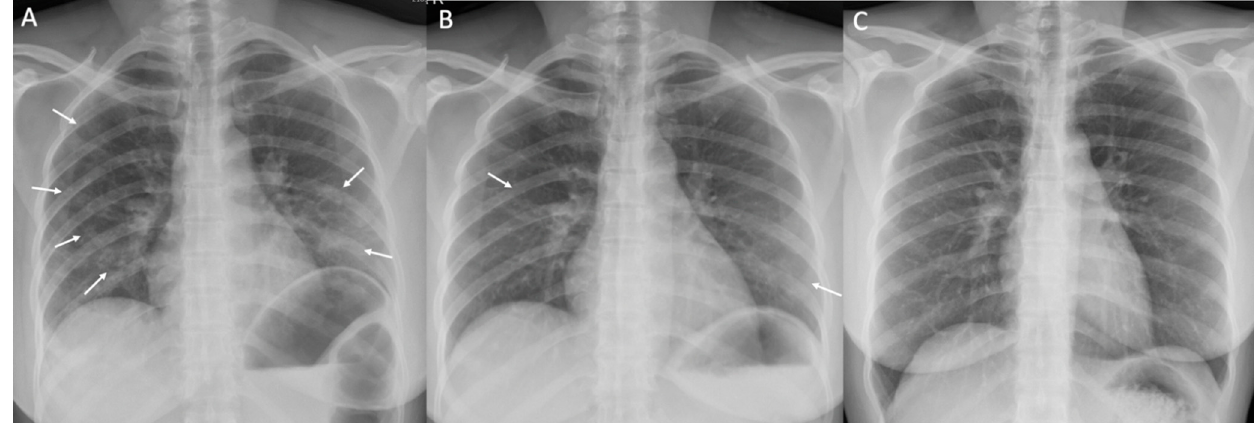
Figure 2. Chest X-rays during the hospitel course determined by Rama Co-RADS in one representative patient. A 43-year-old woman with a body mass index of 24 kg/m 2 presented with cough and dyspnea for 1 day (13 days after contact). ( A ) Initial chest X-ray obtained on admission (day 2 of illness) shows multifocal poorly defined patchy opacities and/or consolidation (arrows) in both lungs, compatible with COVID-19 pneumonia (Rama Co-RADS category 5). ( B ) Follow-up chest X-ray obtained on day 6 of illness and after 4 days of favipiravir and corticosteroid treatment shows a marked improvement with faint residual opacities (arrows) in some affected areas. ( C ) Follow-up chest X-ray obtained on day 13 of illness shows complete resolution of COVID-19 pneumonia.